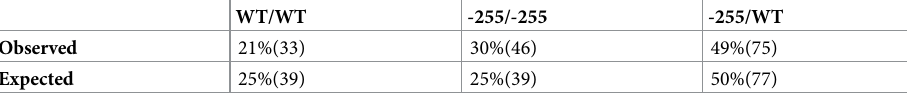
Table 2. Observed/Expected ratios of Nes enhancer deleted transient embryos.